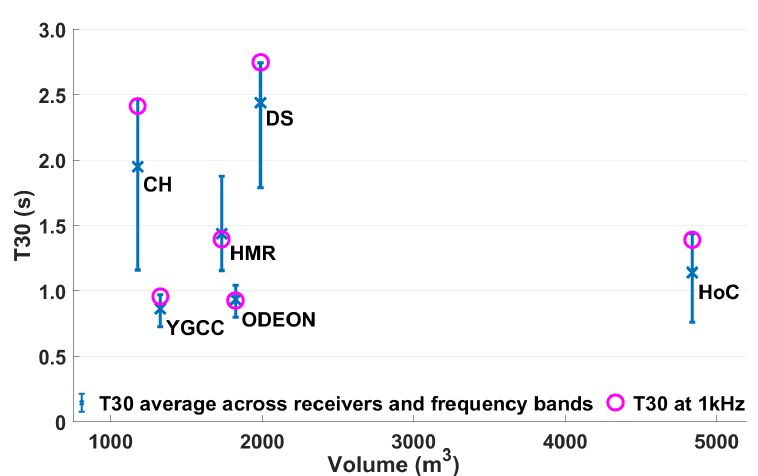
Figure 23. Average T30 results across all frequency bands of the five measured spaces and the ODEON model versus their volume. Error bars represent the deviation of the individual positions for each site, while the pink circle represents the averaged T30 values at 1